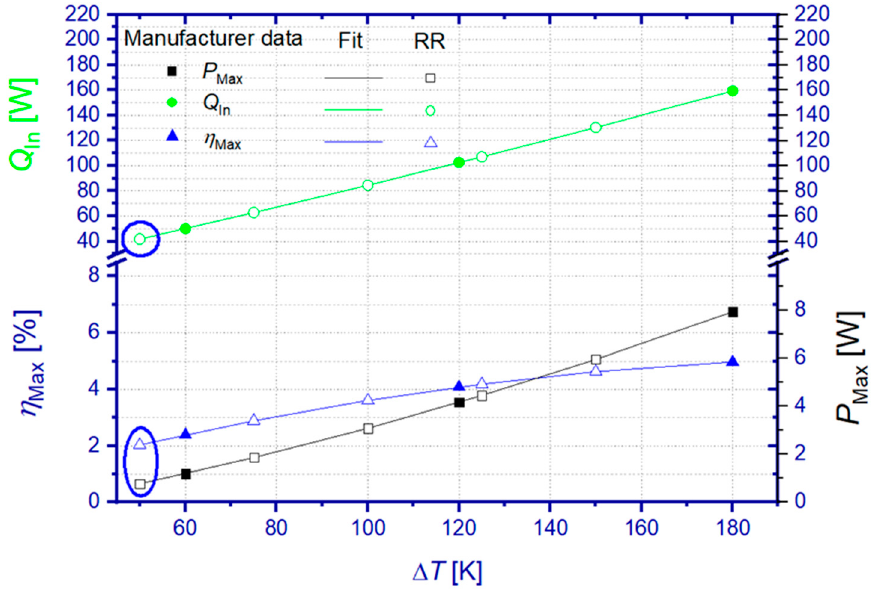
Figure 3. Manufacturer specifications (full symbols) on maximum power output, incident heat flow at maximum efficiency conditions, and maximum efficiency in dependence on the applied temperature difference across the TEM. The manufacturer specifications refer to a cold side temperature of T C = 50 °C. Manufacturer’s reference data (blank symbols) for comparison of RR results were derived from polynomial approximations (lines) of given module specifications. Extrapolated reference values obtained from approximation functions of manufacturer data are limited to the lowest Δ T = 50 K and indicated by blue circles.